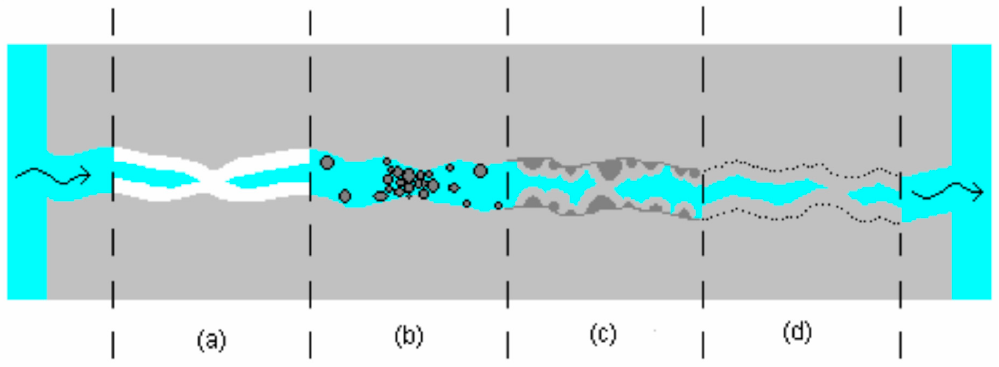
Figure 7. Different mechanisms of autogenous healing: ( a ) the deposition of CaCO 3 or Ca(OH) 2 crystals; ( b ) filling of the crack by pollutants in the water and loose concrete particles from spalling; ( c ) formation of new silicates by hydration of unreacted cement particles near the edge of the fracture and ( d ) expansive reaction of the hydrated cementitious matrix [163].